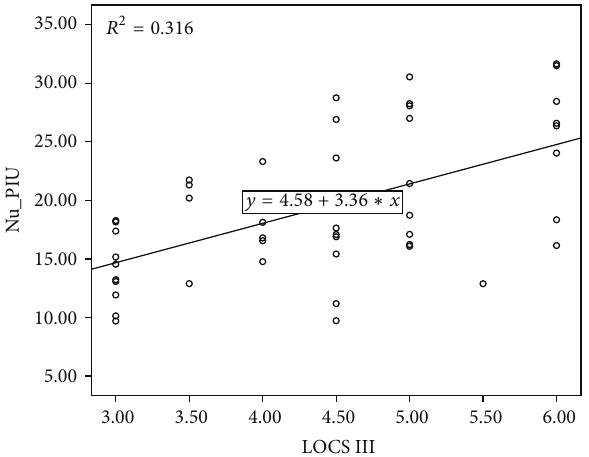
Figure 3: The relationship between lens nuclear densities measured using optical coherence tomography (OCT) and LOCS